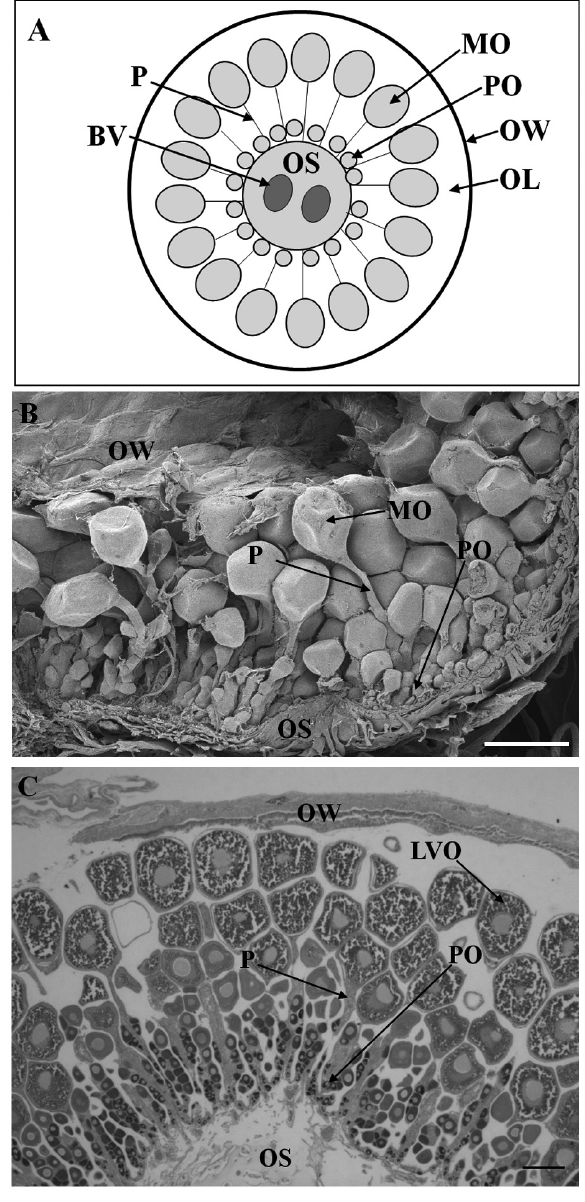
Fig . 2. – Transverse sections of lionfish ovaries depicting asyn- chronous oocyte production and cystovarian morphology. A) Line drawing, adapted from Koya and Muñoz (2007), B) electron micro- graph (scale bar = 500 µm), and C) histological photomicrograph of an ovary whose most advanced oocytes are in the late vitellogenic stage (scale bar = 250 µm). BV, blood vessels; LVO, late vitellogen- ic oocyte; MO, maturing oocyte; OL, ovarian lumen; OS, ovarian stroma; OW, ovarian wall; P, peduncle; PO, primary growth